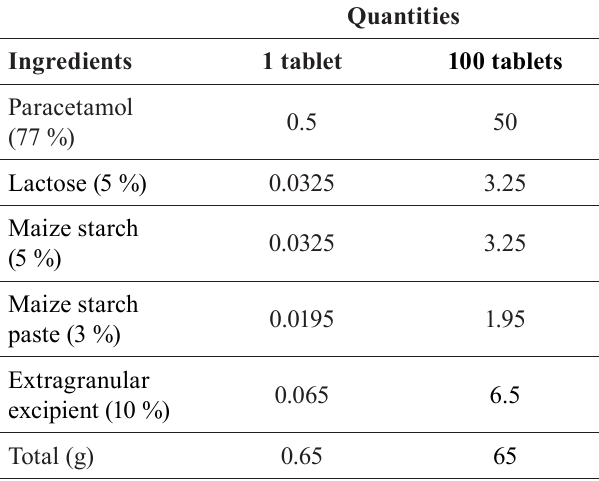
TABLE I - F ormula for preparing paracetamol granules